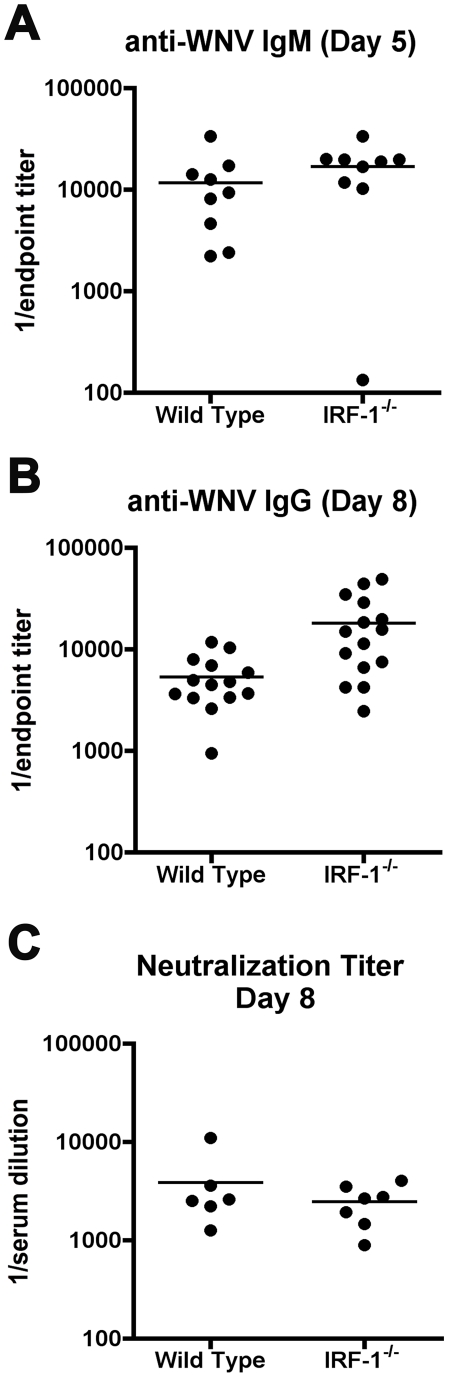
Antibody responses in IRF-1
-/- mice remain intact after WNV infection.
A-B. Wild type and IRF-1
-/- mice were inoculated with 102 PFU of WNV-NY by footpad injection and serum samples collected on days 5 and 8 after subcutaneous WNV infection were assayed by ELISA for WNV-E specific (A) IgM and (B) IgG. Titers are expressed as a scatter plot of the reciprocal serum dilution that was three standard deviations above background (endpoint titer). All IgM and IgG titers were not statistically significant from wild type mice (P > 0.1). C. Neutralizing antibody titers in wild type and IRF-1
-/- mice from serum collected at day 8 after infection. Filled circles reflect samples from individual mice and reflect the serum dilution that inhibits 50% of infection of Vero cells as judged by a focus reduction neutralization assay. No statistical difference (P > 0.3) was observed.